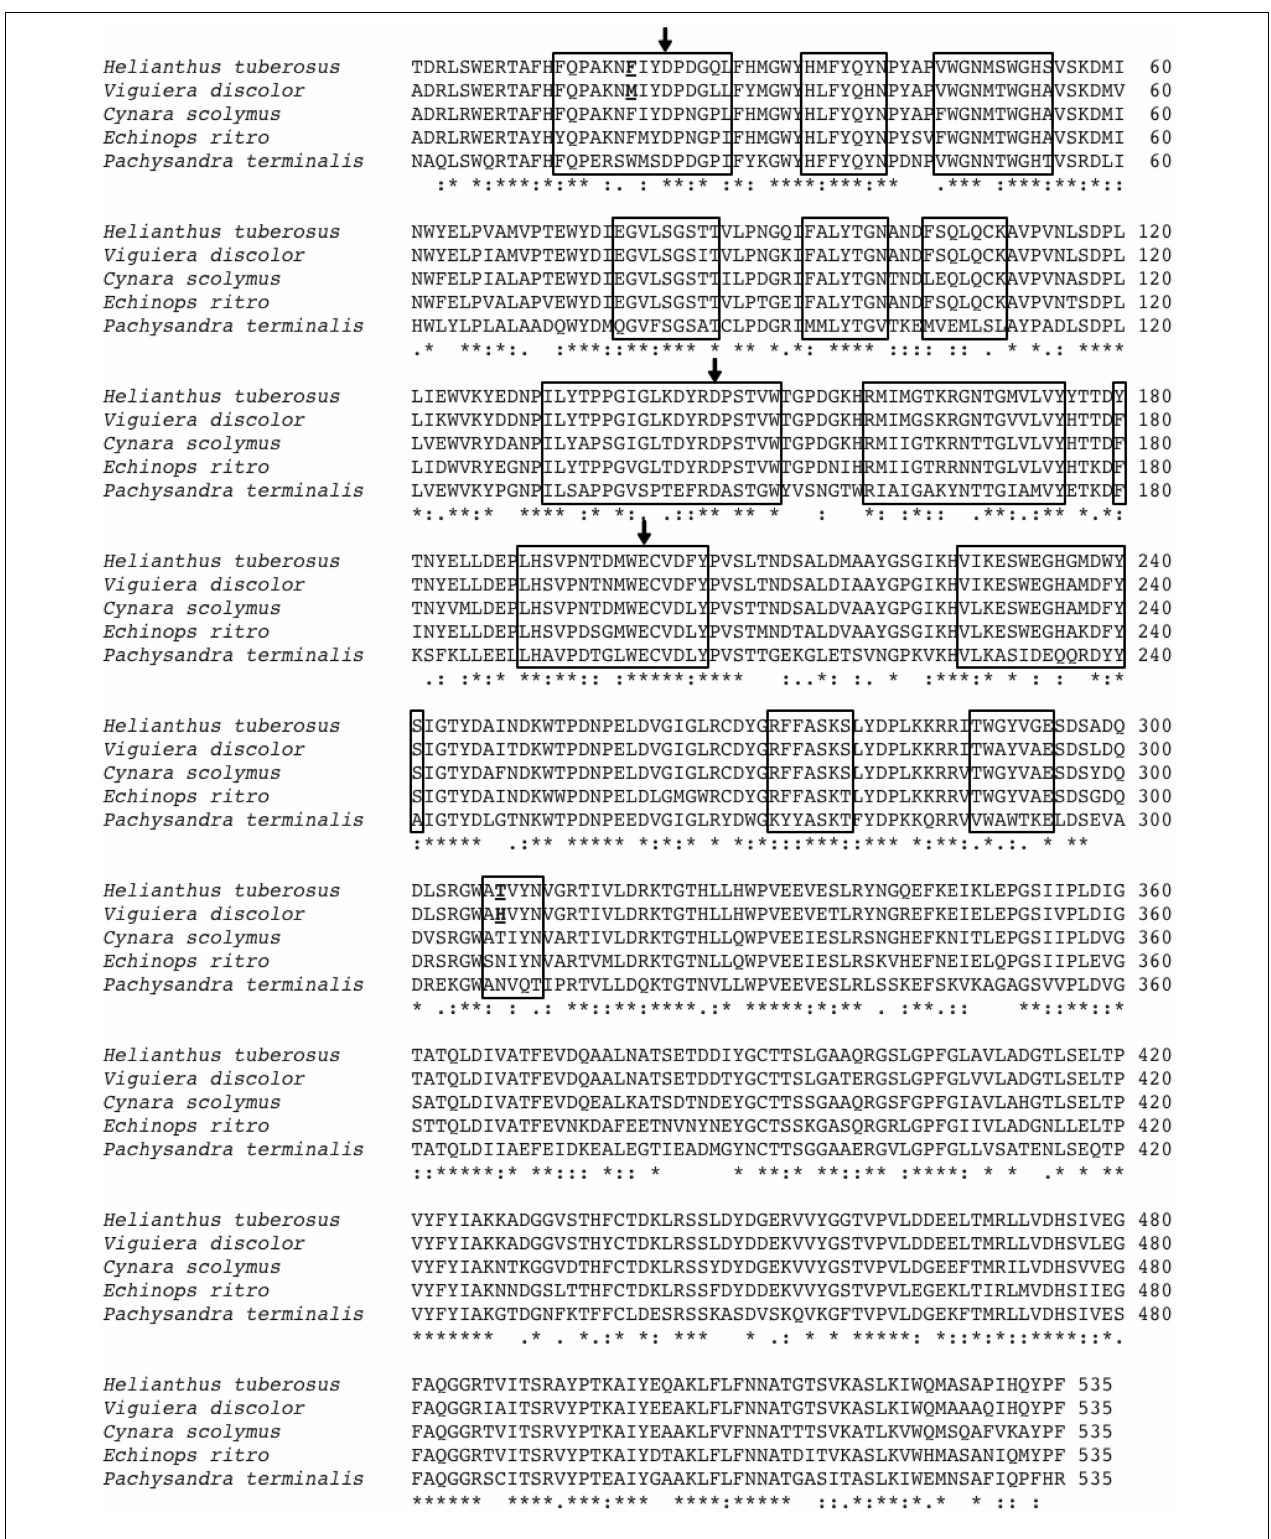
FIGURE 1 | Alignment of the amino acid sequences of the low DP 1-FFT of Ht and the three known high DP 1-FFTs of Echinops ritro , Cynara scolymus and Vd . Also included is the sequence of the Pachysandra terminalis 6-SST/SFT on which the 3D homology models